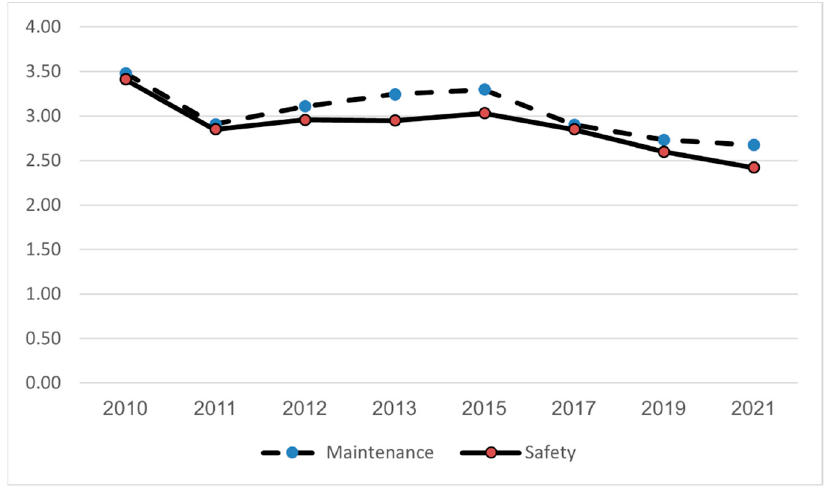
Figure 13. Maintenance and safety indicators in public building case study 2010–2021.